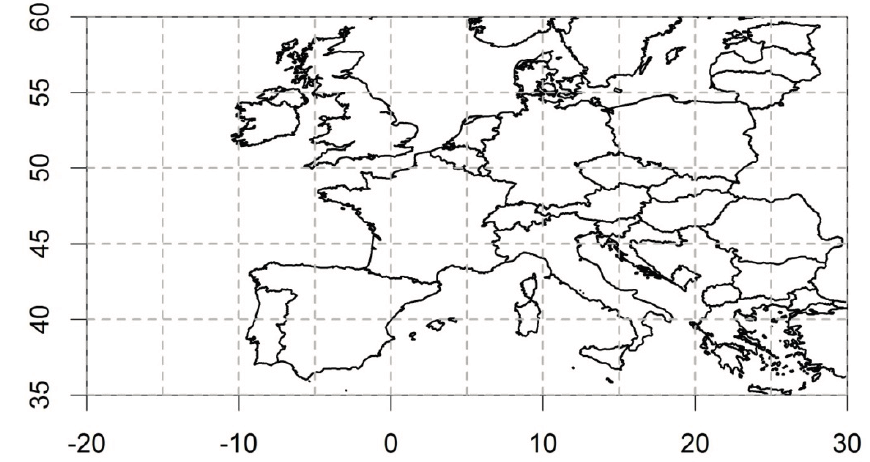
Figure 1. Area for which CRUTEM4v surface temperature anomaly data were extracted and analysed for each 5° × 5° grid box using multi-scale entropy (MSE). Country outlines data source: GISCO—Eurostat (European Commission). Administrative boundaries: EuroGeographics © , UN-FAO,